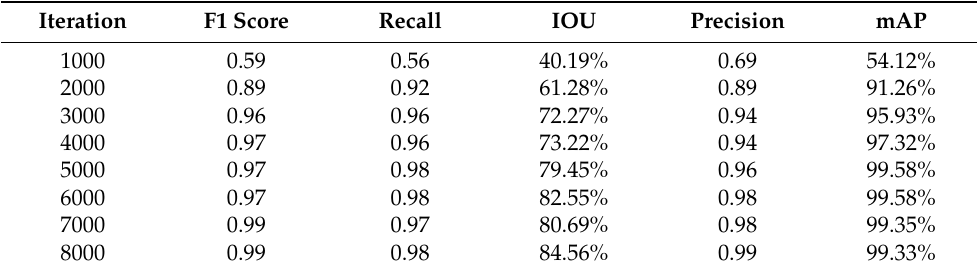
Table 6. Testing results of F1-score, recall, IOU, precision, mAP.